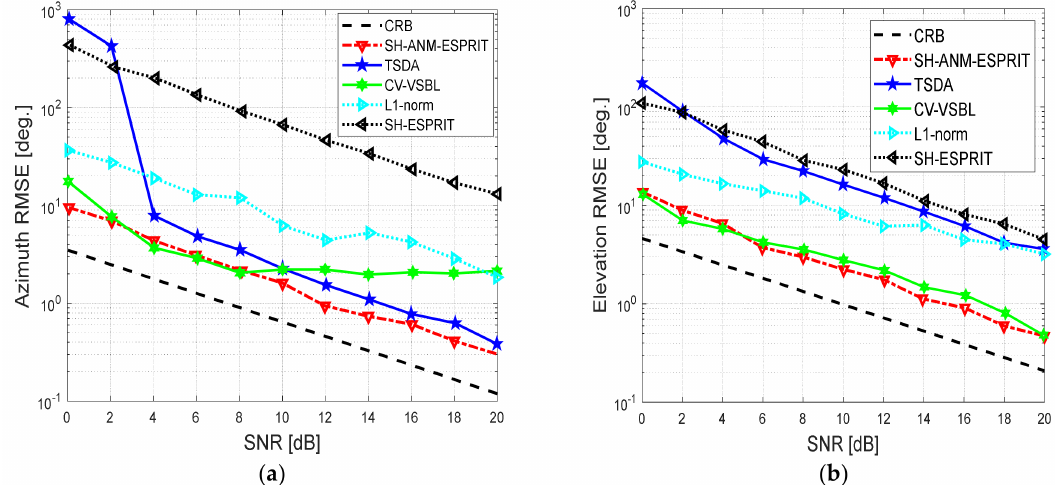
Figure 6. Comparison of performance with various SNRs under correlated sources ( θ , ϕ ) = ( 30 ◦ ,60 ◦ ) and ( 40 ◦ ,130 ◦ ) , 250 snapshots, and α = 0.7. ( a ) Azimuth. ( b ) Elevation.